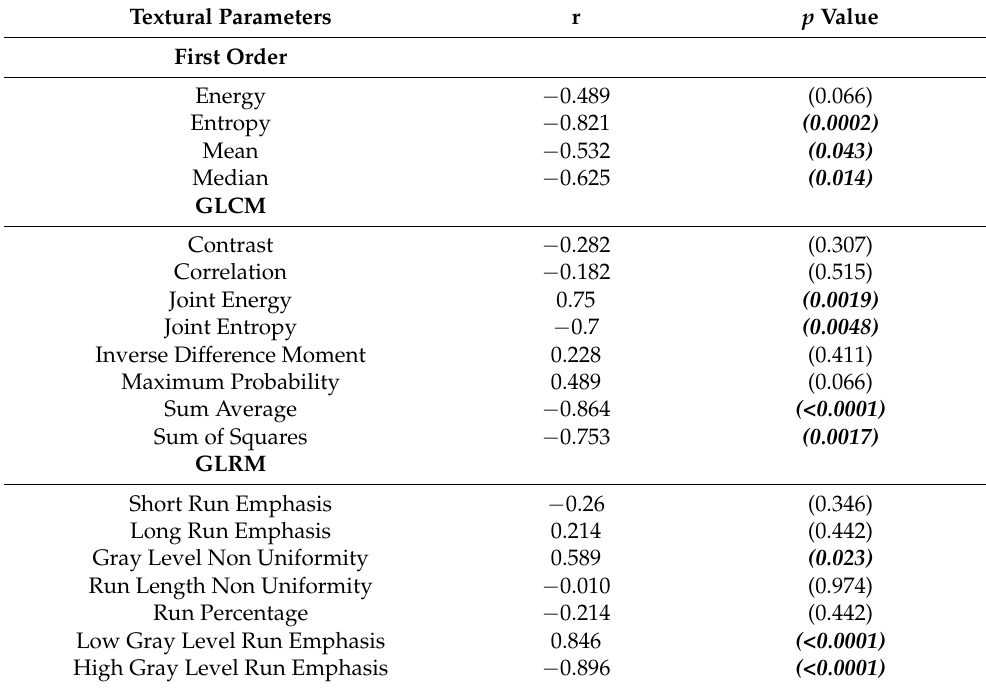
Table 2. Correlation between textural parameters and failure load for the greater trochanter in the MR images. In bold and italic, p -value under 0.05. (aBMD: areal bone mineral density; GLCM: grey level coocurrence matrix; GLRM: grey level run-length